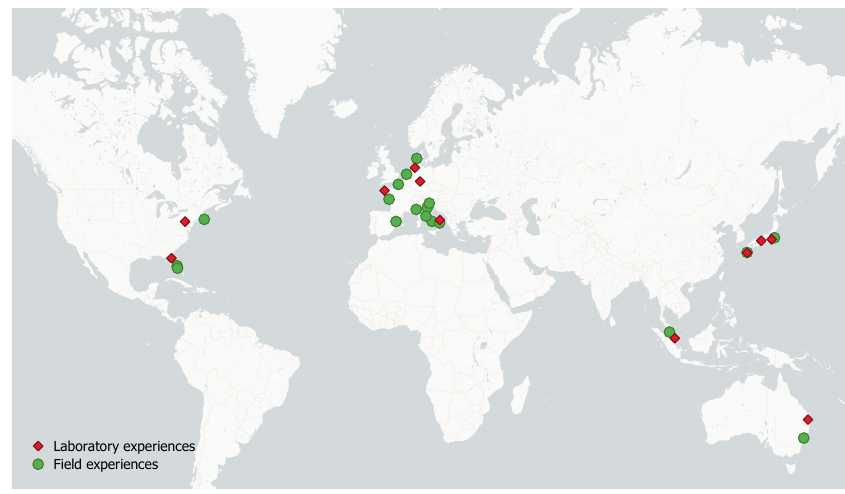
Figure 1. Maps of the field and laboratory experiences around the